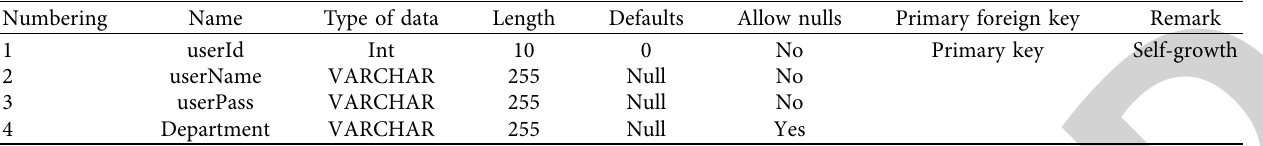
Table 3: User information